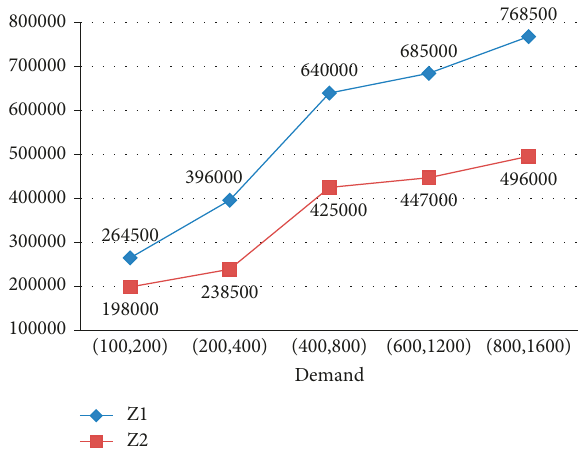
Figure 10: Effect of demand on the objective functions.